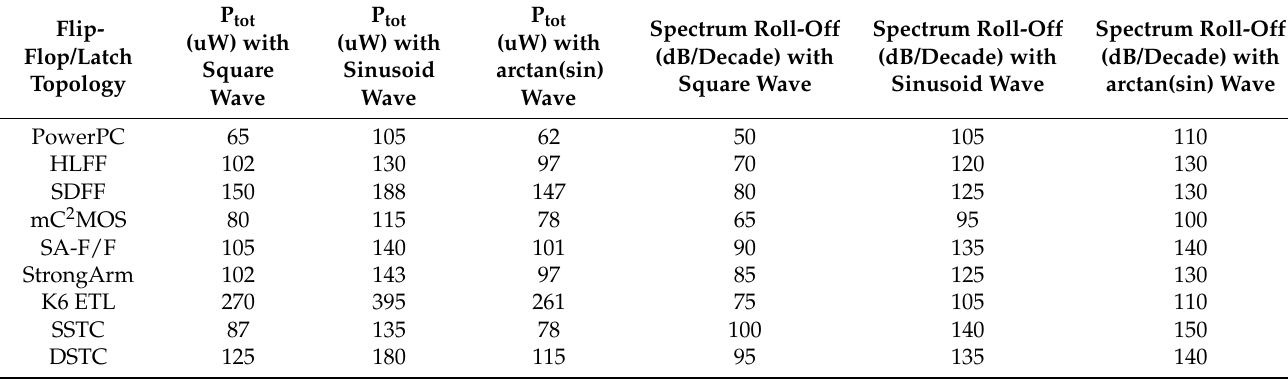
Table 5. Comparison of simulation results using the BSIM4 transistor